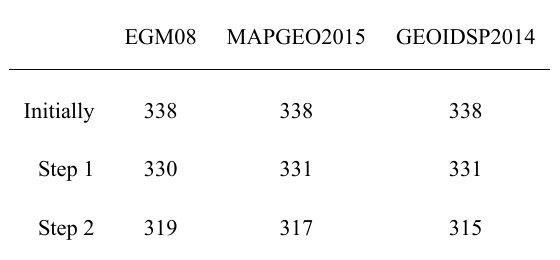
Number of remaining points after each filtering step for EGM08 model MAPGEO2015 and GEOIDSP2014.